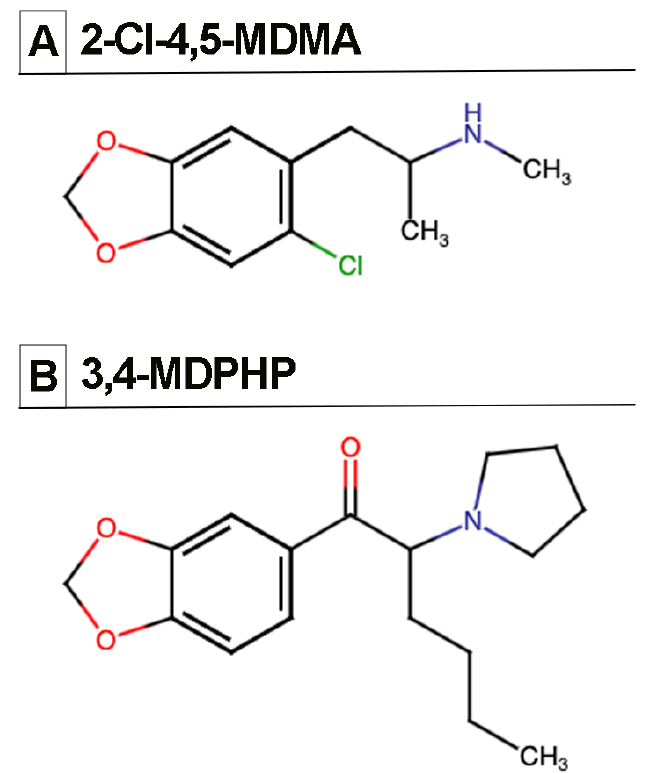
Figure 1. Chemical structures of the two NPSs tested in this study: ( A ) phenethylamine 2-Cl-4,5-MDMA (2-chloro-4,5-methylenedioxymethamphetamine); ( B ) synthetic cathinone 3,4-MDPHP (3 ′ -4 ′ -methylenedioxy-alpha-pyrrolidinoexanophenone).